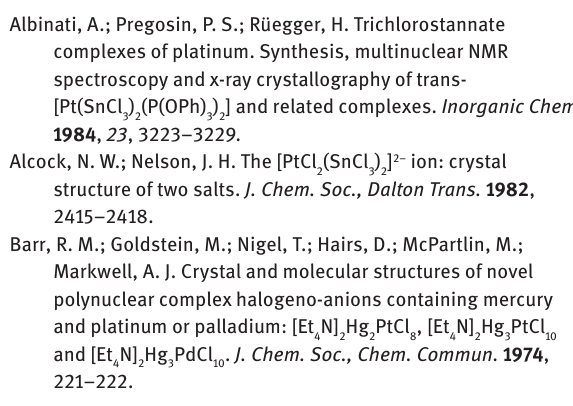
{ Si(OMe) SnCl ] 3 3 2